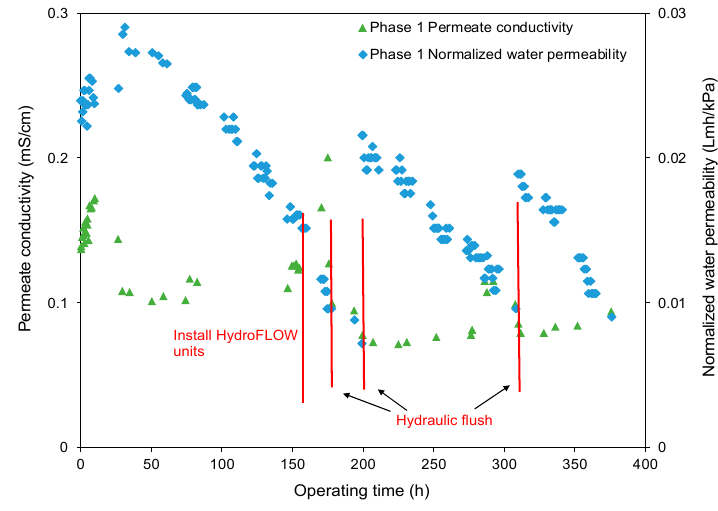
Figure 9. Permeate conductivity and Normalized water permeability during the Phase 1 experiment.